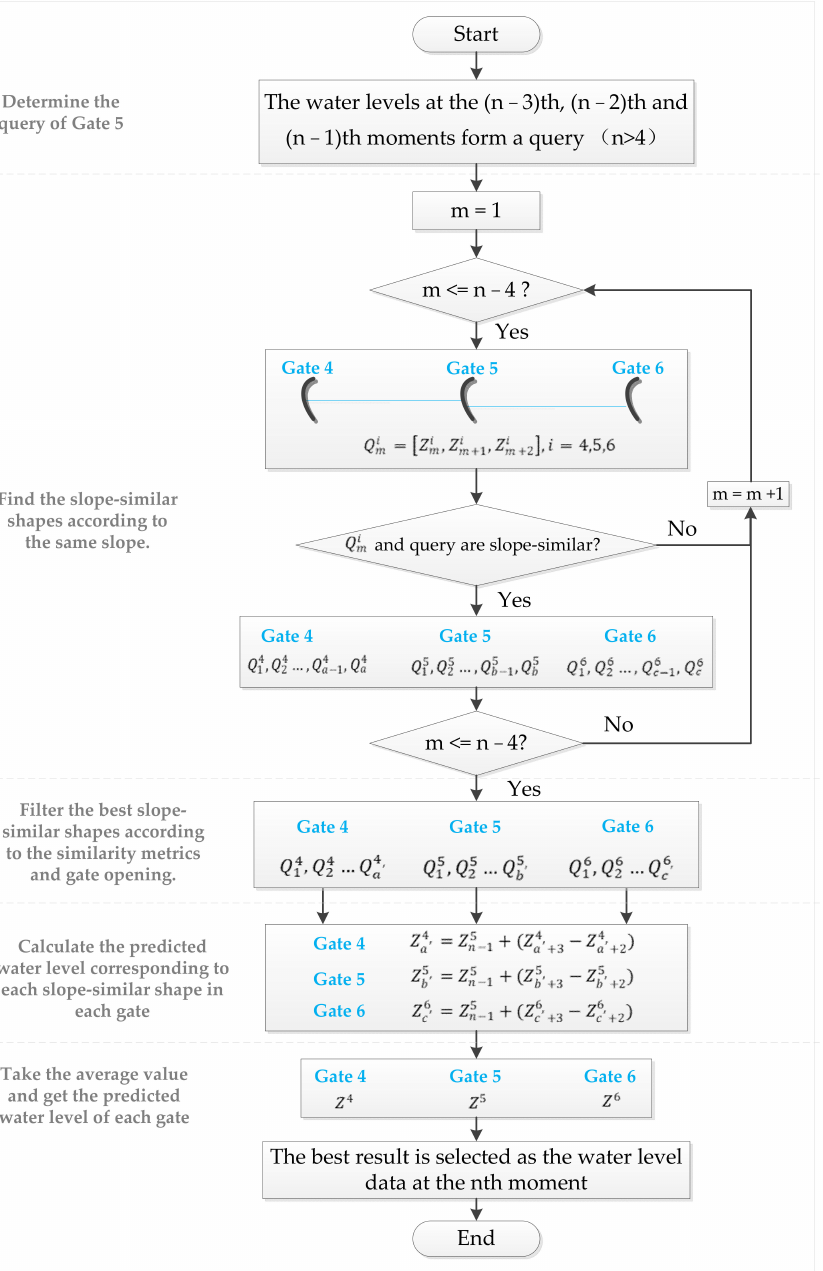
Figure 5. Water level prediction flowchart. It should be noted that query is selected in this paper to verify the effectiveness of the proposed method, but it is always the three consecutive water level data points at the latest moment in actual water level prediction. Z i m is the water level data at the mth moment in the ith gate; Q i m is the dataset consisting of the water level at moment m, m + 1, and m + 2 in the ith gate. a, b, and c are the number of slope-similar shapes in gates 4, 5, and 6, respectively, and after filtering, the numbers are a (cid:48) , b (cid:48) , and c (cid:48) , respectively. For gate 5, Q 5 m is the query when m = n − 3, so it needs to be skipped. Python 3.9 is used to search for slope-similar shapes for each gate and to filter the best slope-similar